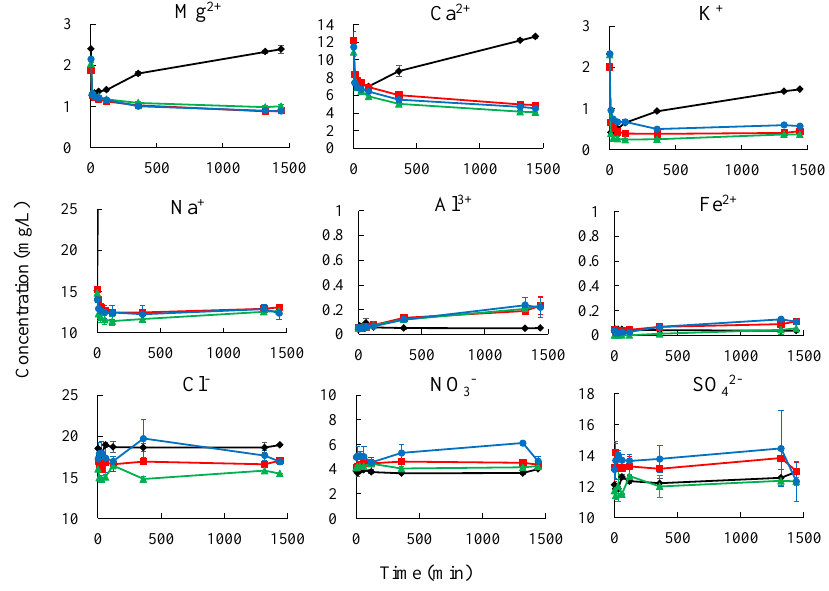
Figure 6. Changes in anion and cation concentrations. ◆ RB, ■ 5-SN, ▲ 5-NP, ● 5-PS.